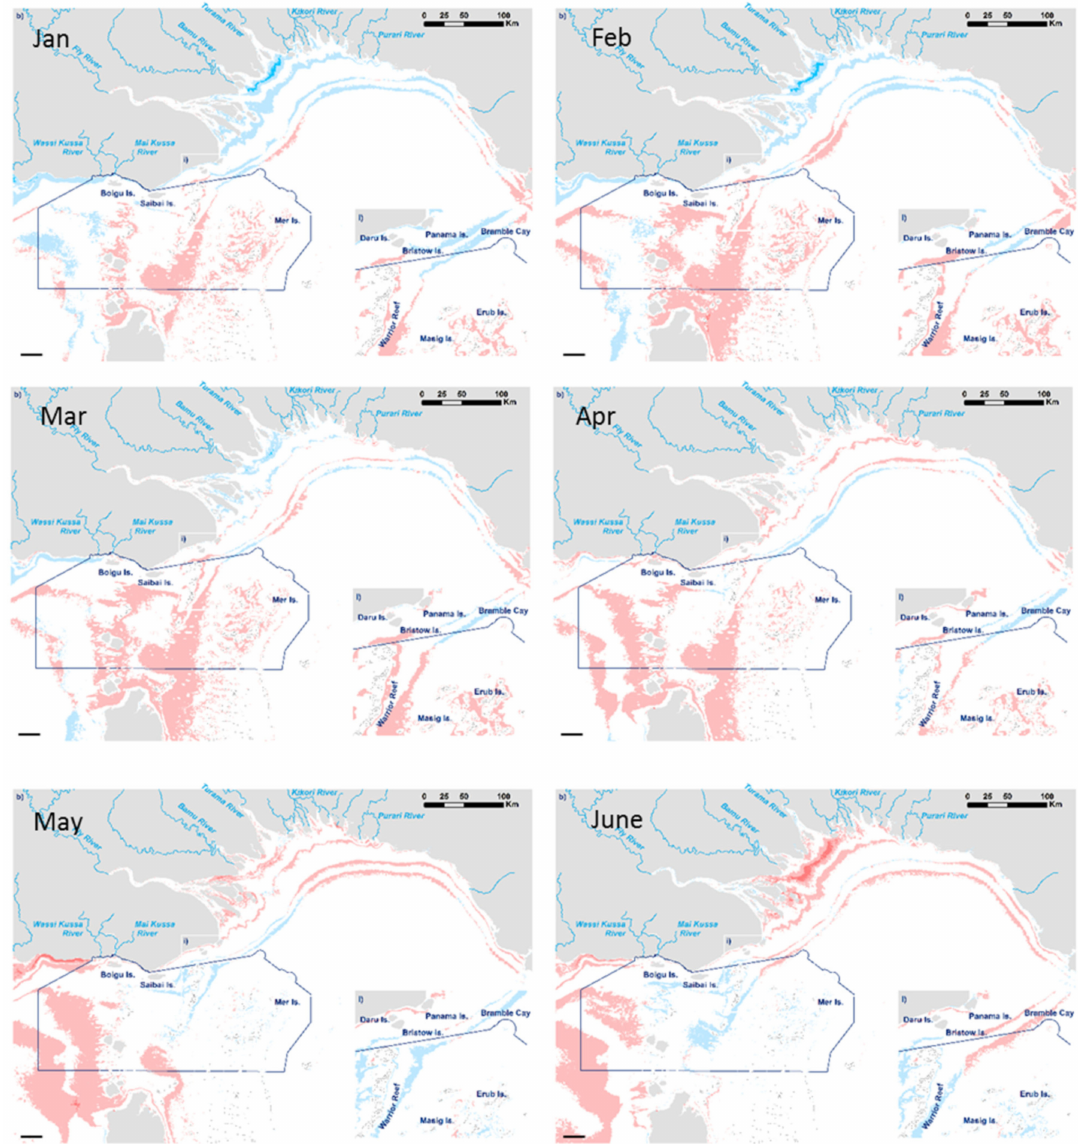
Figure A6. Decadal monthly difference maps illustrating areas with an increase (positive turbidity anomaly) or decrease (negative turbidity anomaly) in turbidity in each month relative to long-term trends: January to June. Reddish colours show areas with higher turbidity levels, blueish coloured areas have lower turbidity levels against the long-term trends. The monthly difference maps are calculated by subtracting the mean decadal monthly median maps (Table 3) and the decadal median map (Figure 4b), where an increase in colour class category means a positive turbidity anomaly (and